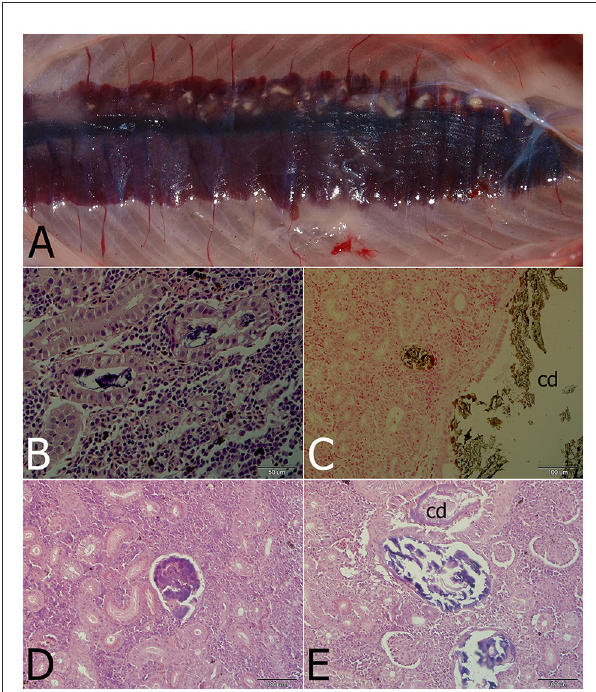
FIGURE1 Nephrocalcinosis in a rainbow trout. (A) Macroscopically visible mineral deposits (white patches) in kidney parenchyma. (B) Renal tubules with strongly basophilic luminal deposits seen in the H&E-stained section. (C) Calcium deposits visualized by von Kossa staining in the convoluted tubule and the collecting duct (cd). (D) Advanced changes of kidney parenchyma associated with calcium deposits located probably in the former glomerulus. (E) Regressive changes of the collecting duct (cd) and/or renal tubules with mineralized luminal content differing in staining properties (H&E).